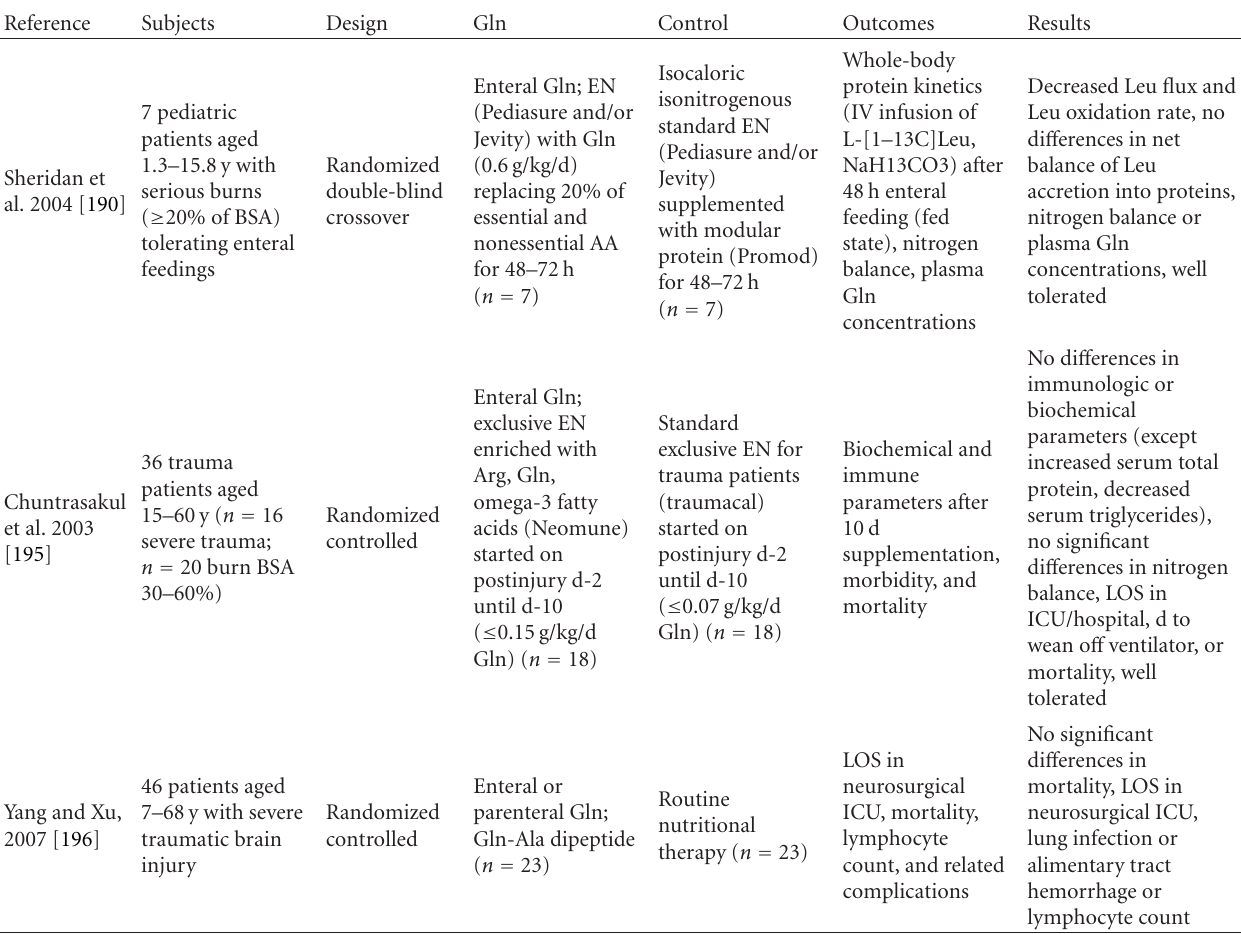
Table 6: Glutamine in pediatric patients with severe